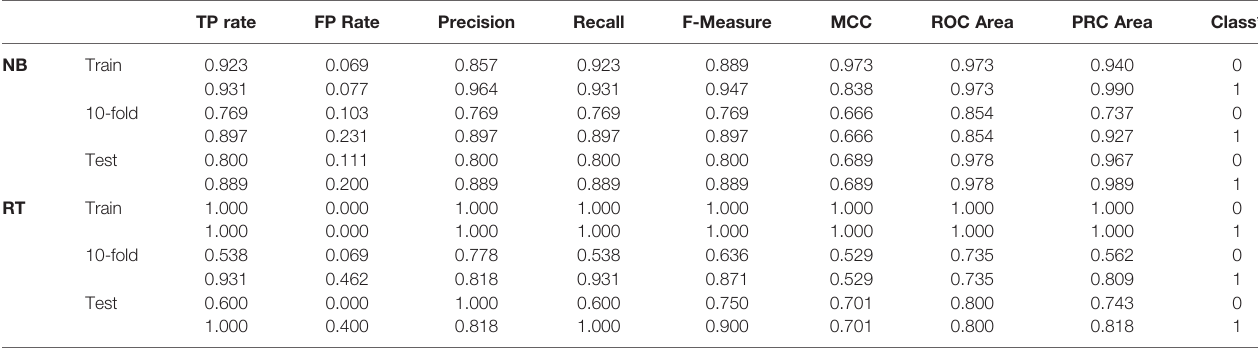
TABLE 5 | Data obtained from the herein developed Regression Models. TP rate FP Rate Precision